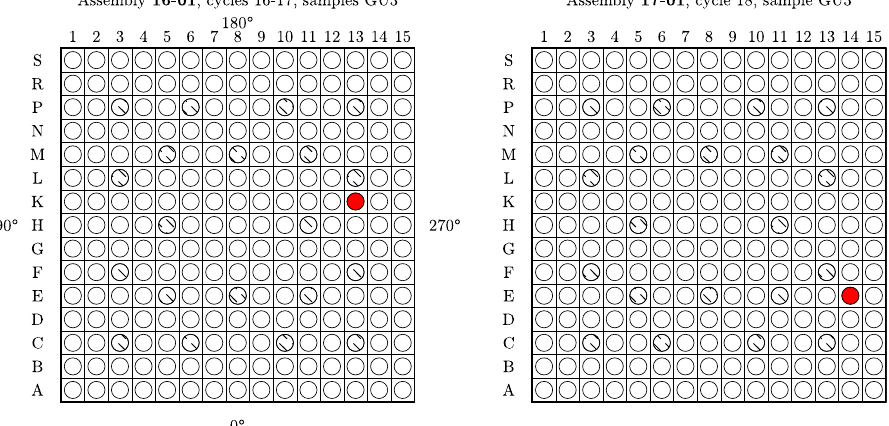
Fig. 1. Radial locations of the rod containing the GU3 sample in both assemblies (in red), before and after relocation (respectively left and right